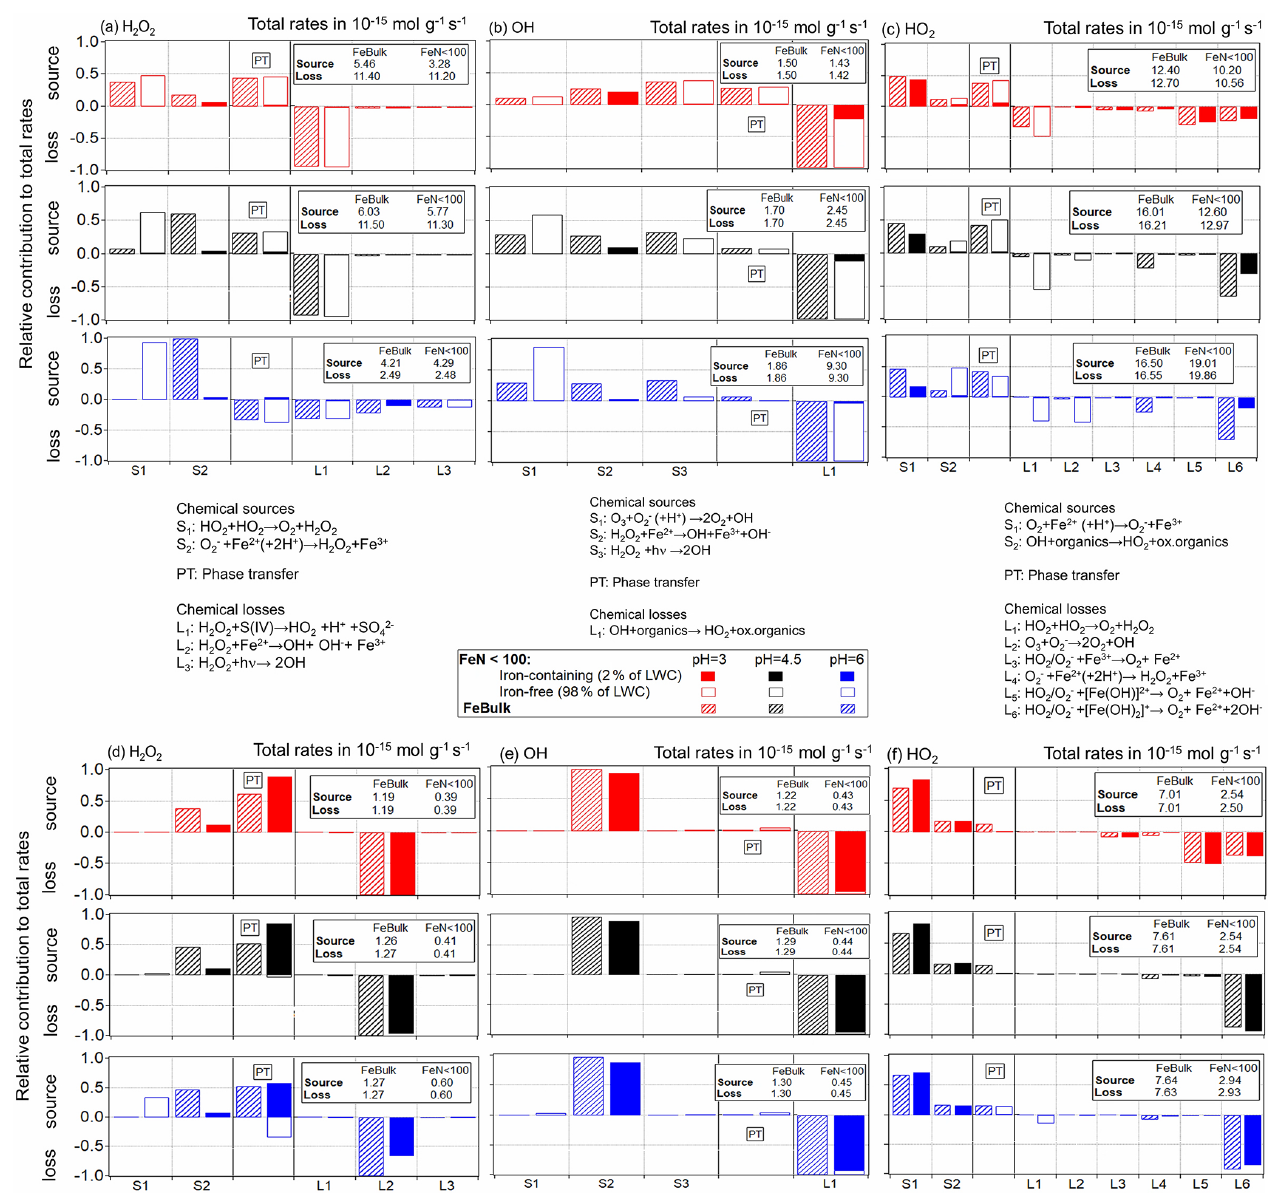
Figure 5. Relative contributions of chemical and phase transfer rates to the total sources and losses of the three ROS. The total rates (moles per gram of air per second) are shown in boxes in the upper right of each panel. For the FeN < 100 approach, the contributions in iron-free and iron-containing droplets (particles) are displayed as open and dashed bars and those for the FeBulk approach as solid filled bars. Simulations were performed at constant pH values of pH = 3 (red), 4.5 (black) and 6 (blue) for cloud conditions (a) H 2 O 2 , (b) OH and (c) HO 2 and aerosol conditions (d) H 2 O 2 , (e) OH and (f) HO 2 . The chemical aqueous-phase source (S) and loss (L) reactions are listed between the